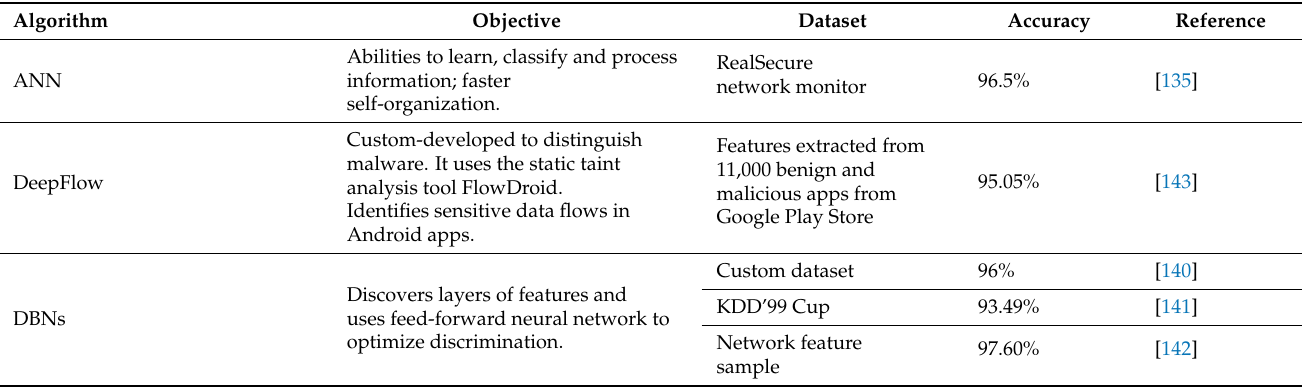
Table 4. Deep machine learning algorithms used in